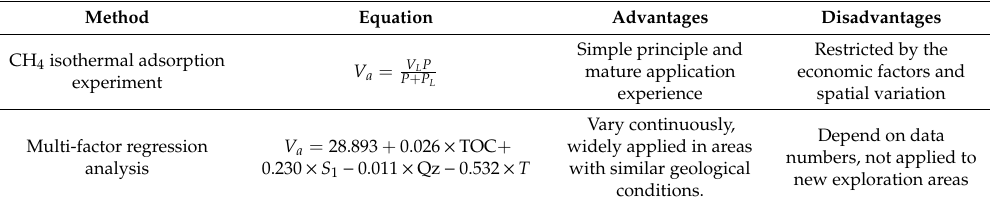
Table 6. Comparison of two main methods for evaluating the